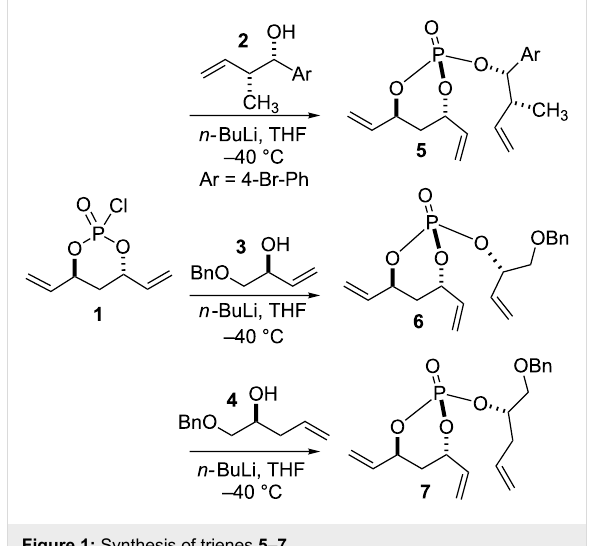
Figure 1: Synthesis of trienes 5 – 7